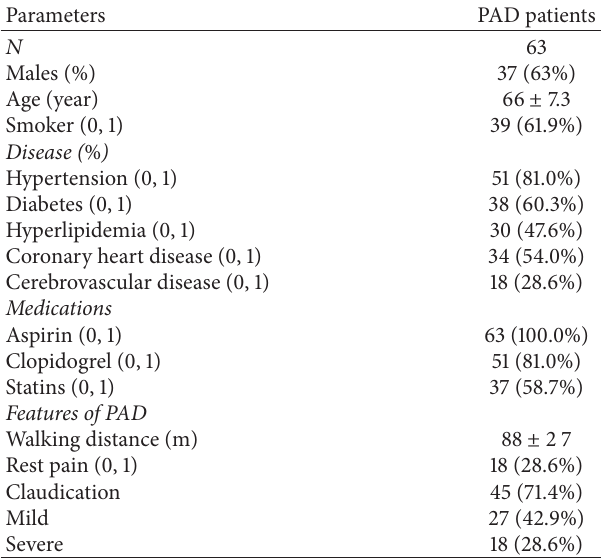
Table 1: General characterization of the studying